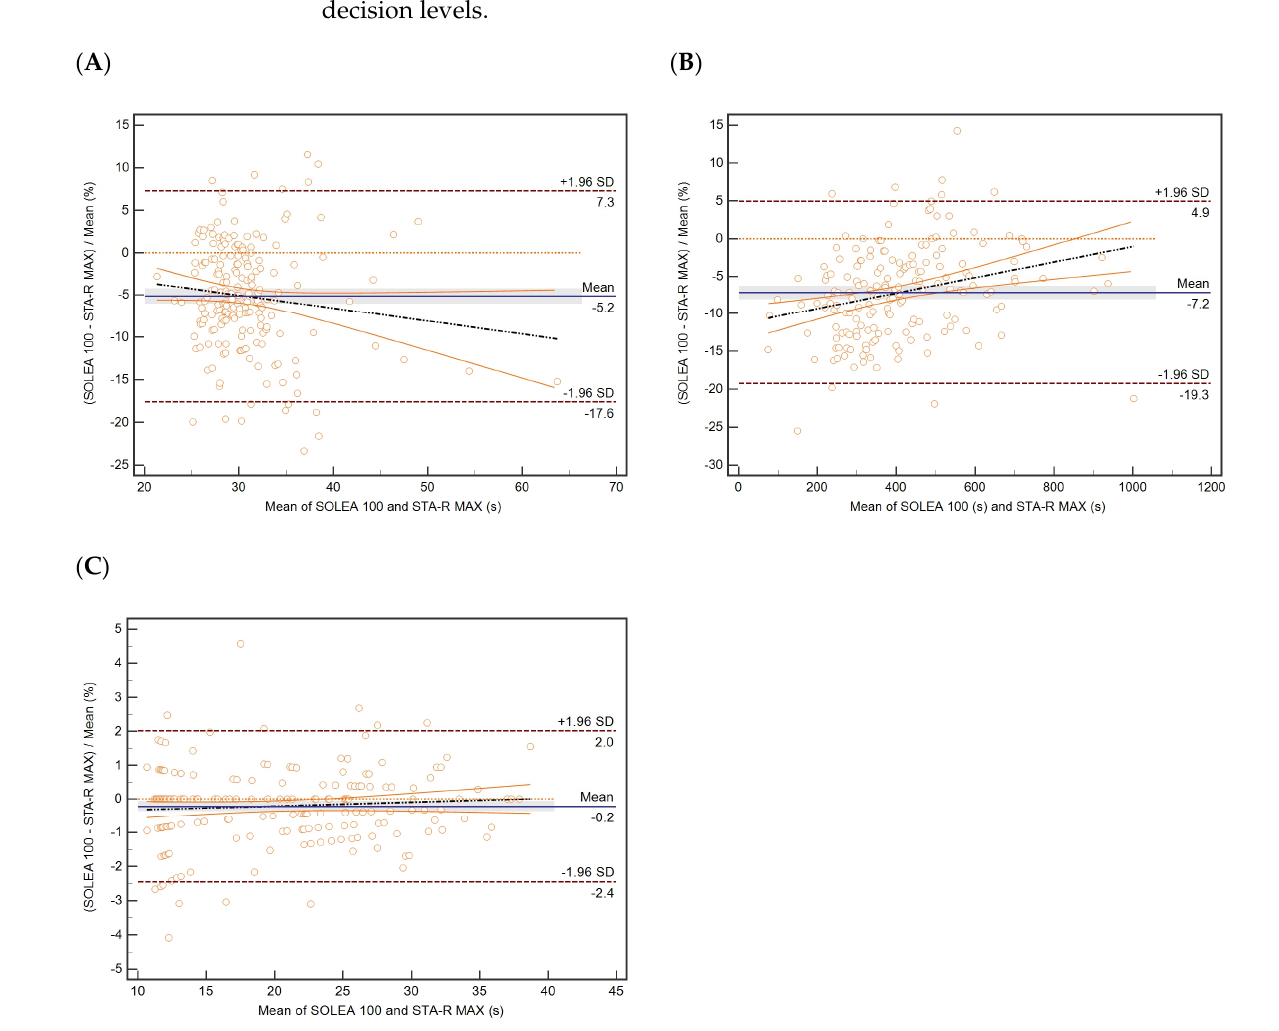
Figure 2. BlandAltman difference plots for ( A ) activated partial thromboplastin time (APTT), 200 samples; ( B ) fibrinogen (FIB), 181 samples; and ( C ) prothrombin time (PT), 206 samples to evaluate the correlation between STA-R MAX and Solea 100. The solid line represents the mean percentage difference, the dotted line the theoretical identity line, the dashed lines the 95% confidence interval, the dot-dashed line the regression line, the solid orange line the 95% CI of the regression line, and the grey band the 95% confidence interval on the mean percentage difference value. Table 2. Comparison among methods for activated partial thromboplastin time, fibrinogen, and prothrombin time.